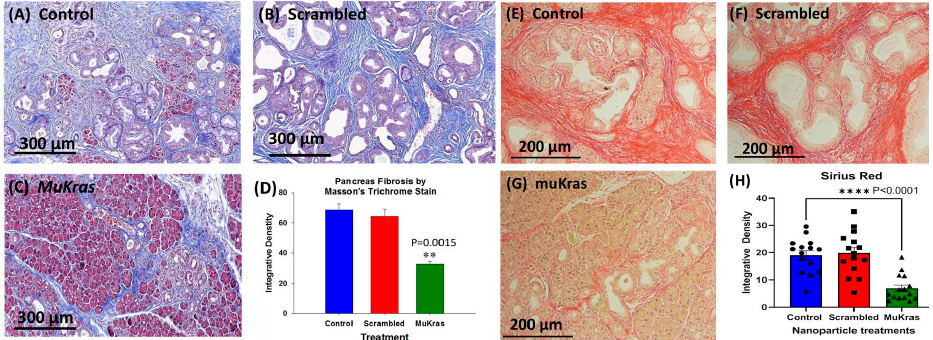
Figure 2. The pancreas extracellular matrix (ECM) shows decreased fibrosis and collagen in mice treated with targeted NP loaded with muKras siRNA. ( A ) Representative Masson’s trichrome stain of a control mouse pancreas shows extensive fibrosis and high grade PanIN lesions. ( B ) Representative image from the pancreas of a mouse treated for 4 months with targeted scrambled siRNA also shows extensive pancreatic fibrosis. ( C ) The pancreata from mice treated with the targeted NP loaded with muKras siRNA have less fibrosis by Masson’s trichrome stain, fewer PanINs, and preservation of the normal pancreas acinar cells in the parenchyma. ( D ) Quantitative analysis of the amount of fibrosis with computerized integrative density shows significantly less fibrosis in the KC mice treated with targeted NP loaded with muKras siRNA ( p = 0.0015; compared to control & scrambled –treated; two-way ANOVA). ( E ) Representative image of a Sirius red stained pancreas section of control mice and ( F ) in the pancreas of mice treated with the scrambled siRNA loaded NP. ( G ) A decrease in the Sirius red staining was observed in the pancreas of the KC mice treated with the muKras loaded NPs. ( H ) Quantitative analysis of the amount of fibrosis with computerized integrative density shows significantly less fibrosis in the KC mice treated with targeted NP loaded with muKras siRNA. ( p < 0.001; compared to control & scrambled-treated; two-way ANOVA). ** p < 0.01; **** p < 0.0001. Individual data points are represented by circles, squares and triangles in the columns.